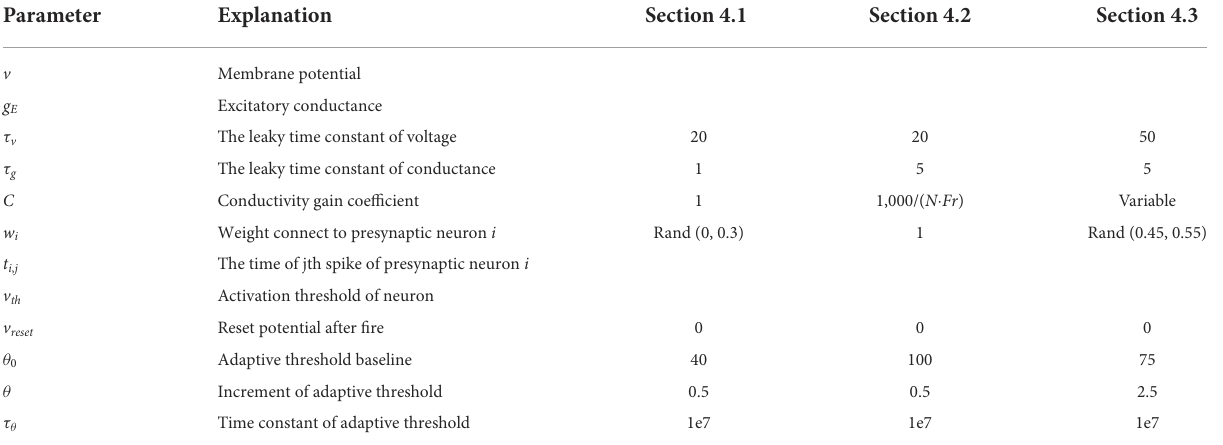
TABLE 1 Explanation and experimental value of the parameters in the LIF neuron